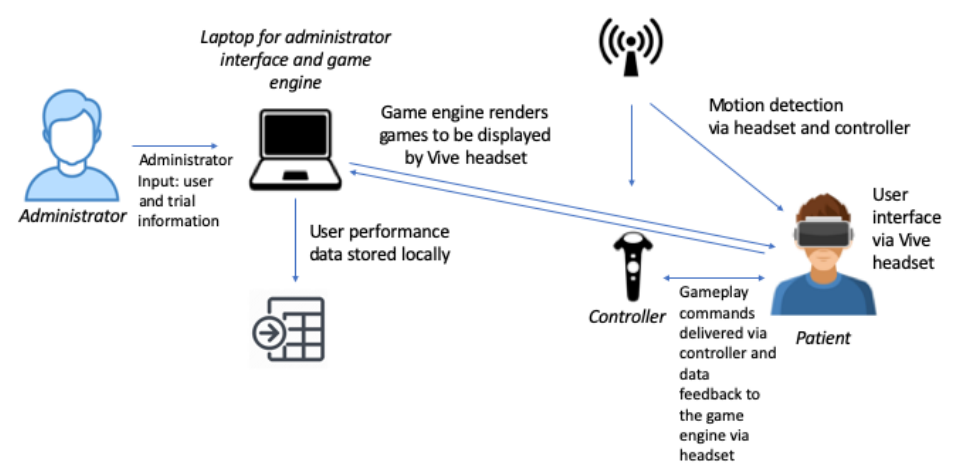
Figure 1. System component diagram showing data flow and user